Question: Write a single sentence explaining what this figure depicts.
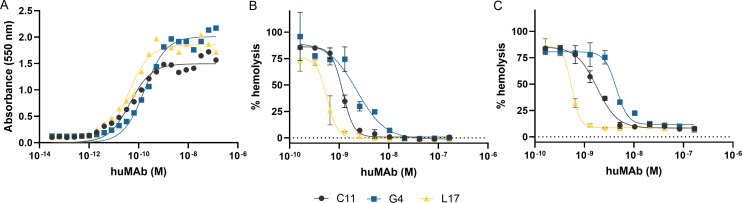
Answer: Anti-SLO huMAbs bind and neutralize SLO. ( A ) Binding of C11, G4, and L17 to immobilized SLO was measured by ELISA, and absorbance was plotted as a function of huMAb concentration in molar (M). Apparent binding affinity (KdApp) was determined by nonlinear regression. Curves are representative of n = 3 independent experiments. ( B ) Inhibition of recombinant (rSLO)-induced hemolysis. RBCs were incubated with four hemolytic units (HU) of rSLO in the presence of increasing concentrations of huMAbs. ( C ) Inhibition of hemolysis induced by GAS culture supernatants. RBCs were incubated with culture supernatant (equivalent to 8 HU of SLO) in the presence of huMAbs. In ( B and C ), hemolysis was quantified relative to complete lysis controls, IC50s were determined by nonlinear regression, and error bars indicate SD of technical replicates. Data are representative of n = 3 ( B ), n = 2 ( C ) independent experiments.